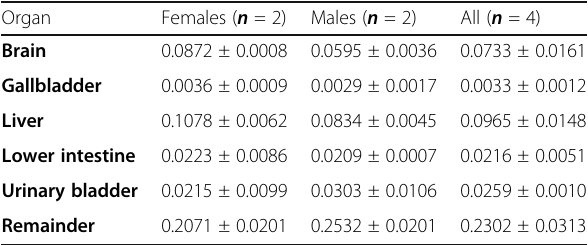
Table 2 Residence times of 11 C-UCB-J in the human brain, gallbladder, lower intestine, liver, lower intestine, urinary bladder, and remainder of the body (hours). All values displayed as mean ± standard